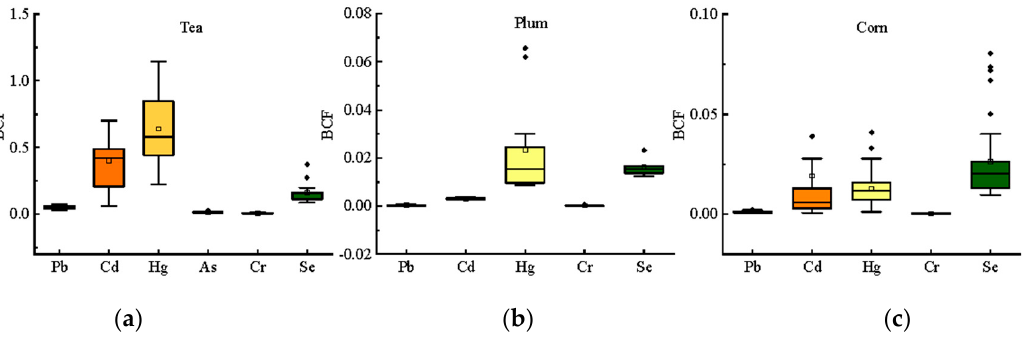
Figure 3. Bioconcentration factors of HMs for different types of crops. ( a ): tea; ( b ): Plum; ( c ): Corn; Mean values ( □ ); and outliers ( ◊ ).